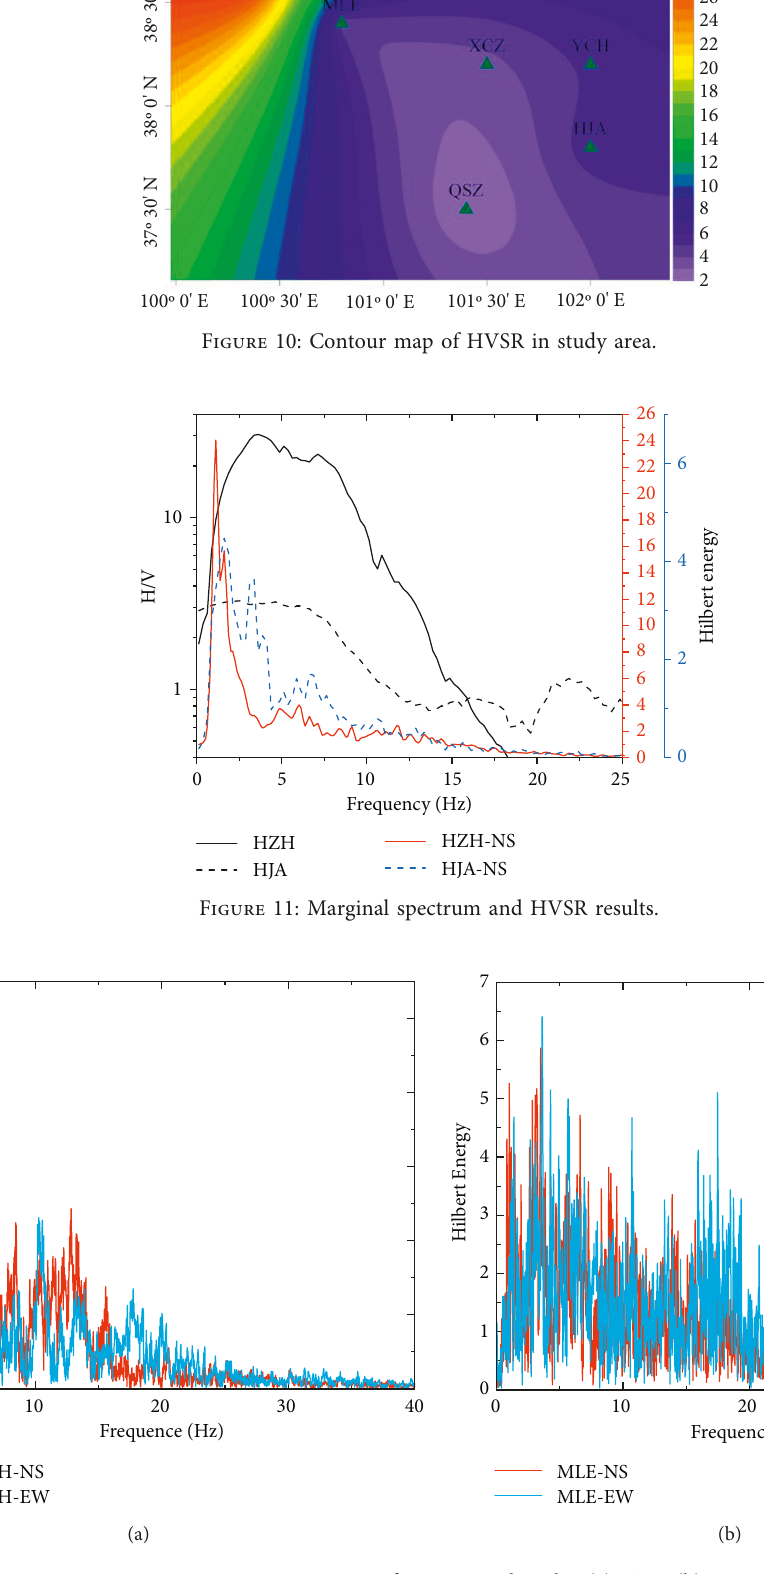
Figure 12: Fourier spectrum of Ms 5.0 earthquake. (a) HZH (b)